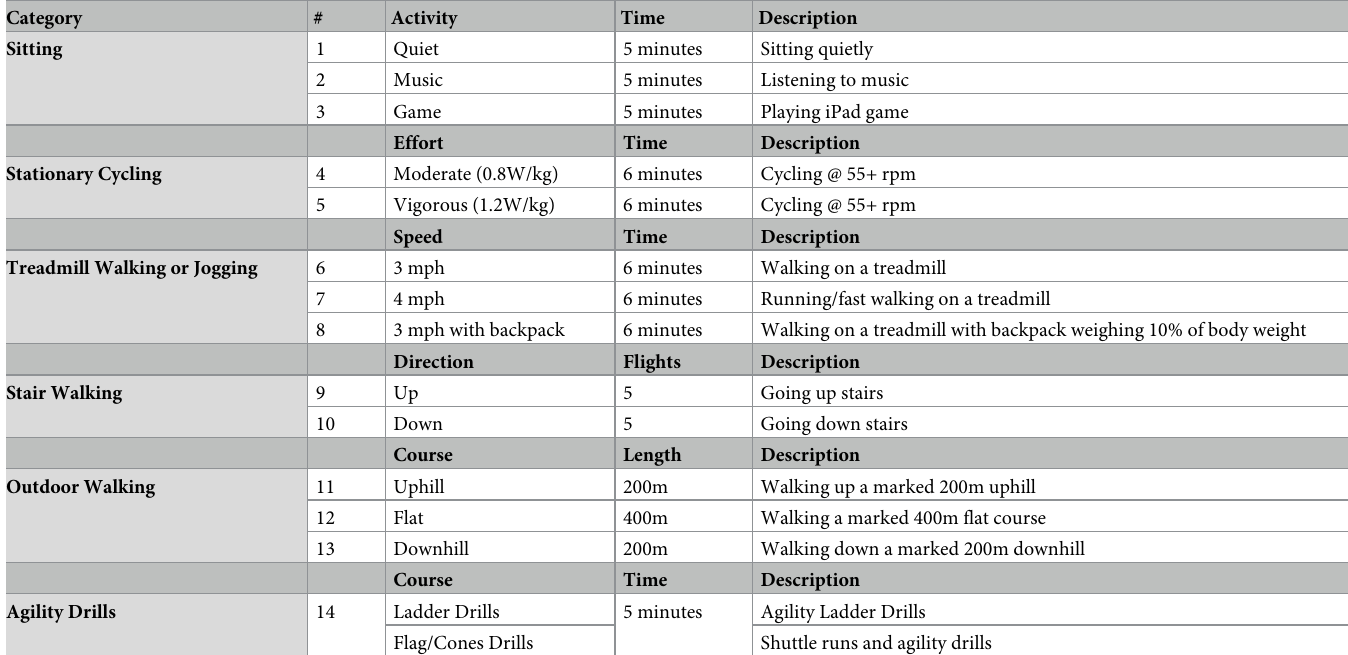
Table 1. Laboratory and field tests conducted for comparison of the Fitbit Charge HR and research-grade